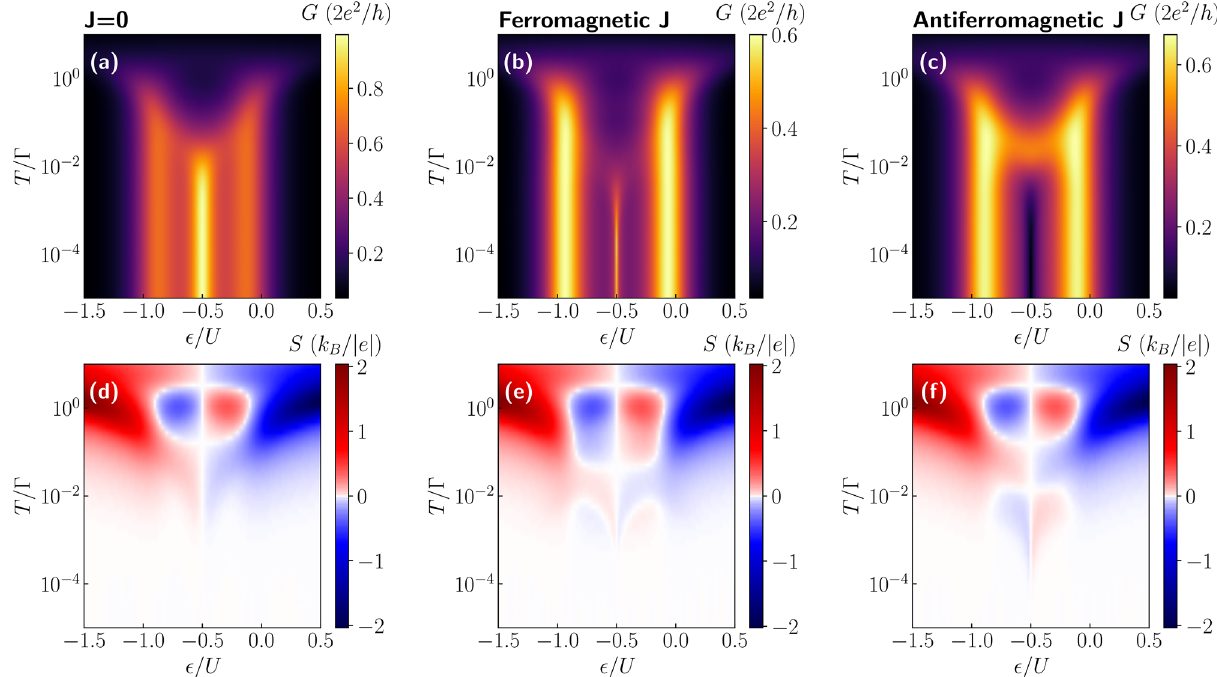
Figure 5. Conductance and thermopower of molecule in ferromagnetic junction. The linear conductance G and thermopower S as a function of the position of molecule’s level ε and temperature T in the case of ( a , d ) J = 0 , ( b , e ) ferromagnetic ( J = 10 T K ) and ( c , f ) antiferromagnetic ( J = − T K ) exchange interaction. The other parameters are the same as in Fig. 2 with p = 20%